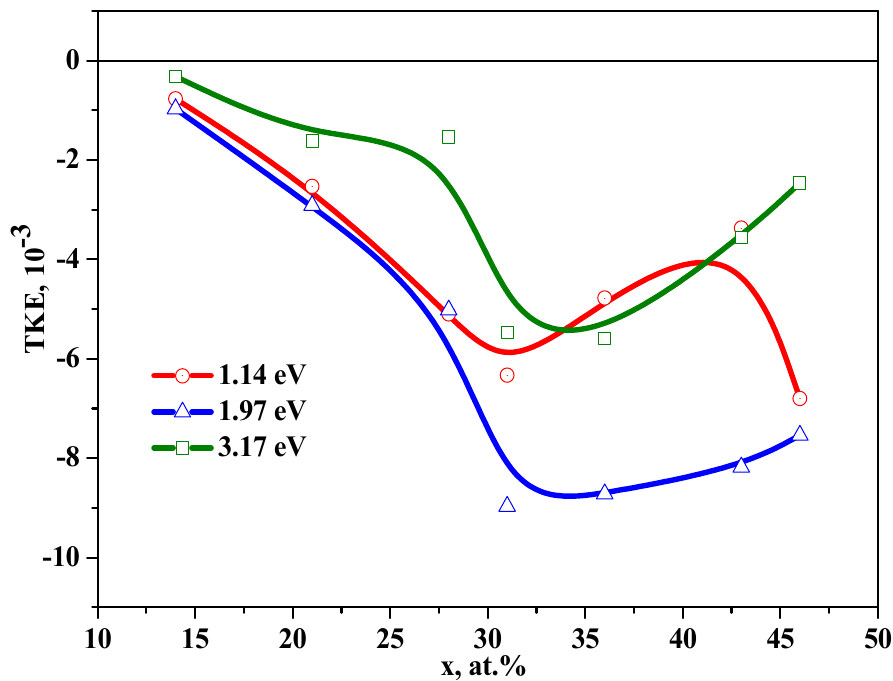
Figure 11. Concentration dependences of TKE for nanocomposites (CoFeZr) x (MgF 2 ) 100 − x on the glass-ceramics substrates for different energy values.